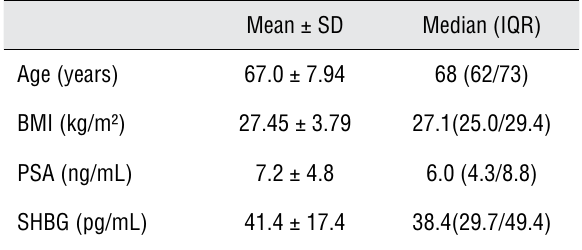
Table 1 - Baseline characteristics of the cohort population.